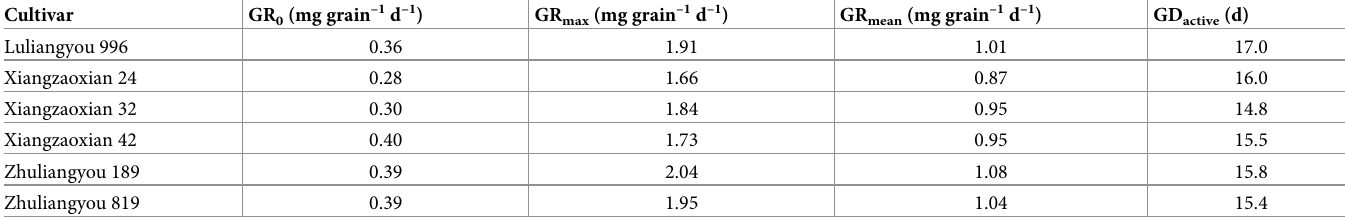
Table 2. Initial grain-filling rate (GR 0 ), maximum grain-filling rate (GR max ), mean grain-filling rate (GR mean ), and active grain-filling duration (GD active ) of six early-season rice cultivars.